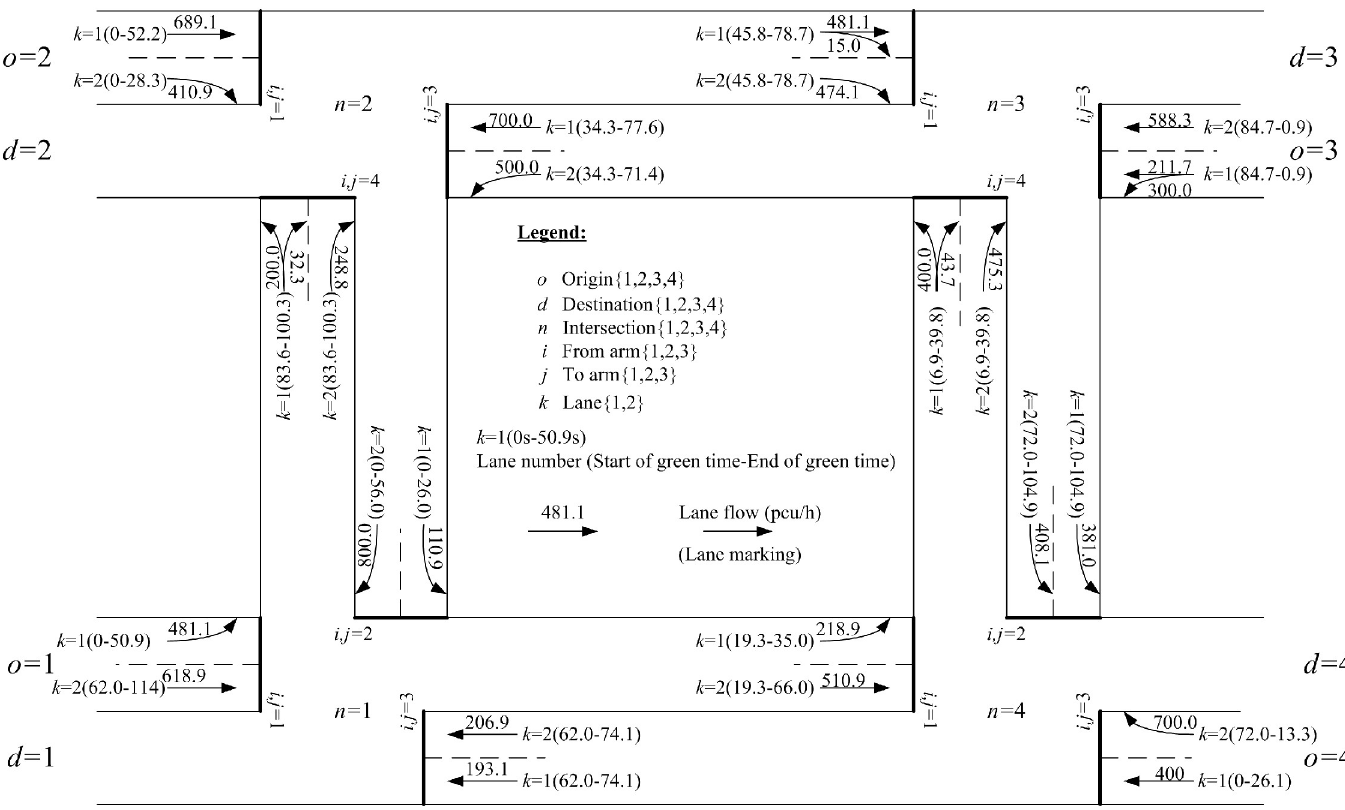
Fig 8. Optimized network configurations including lane markings and assigned lane (turning) flows at individual intersections with W = z ¼ 32 : 9 s (maximized) and z ¼ 1 = 120 : 0 . W o ¼ 4 ; d ¼ 2 ; h o ; d ¼ 1